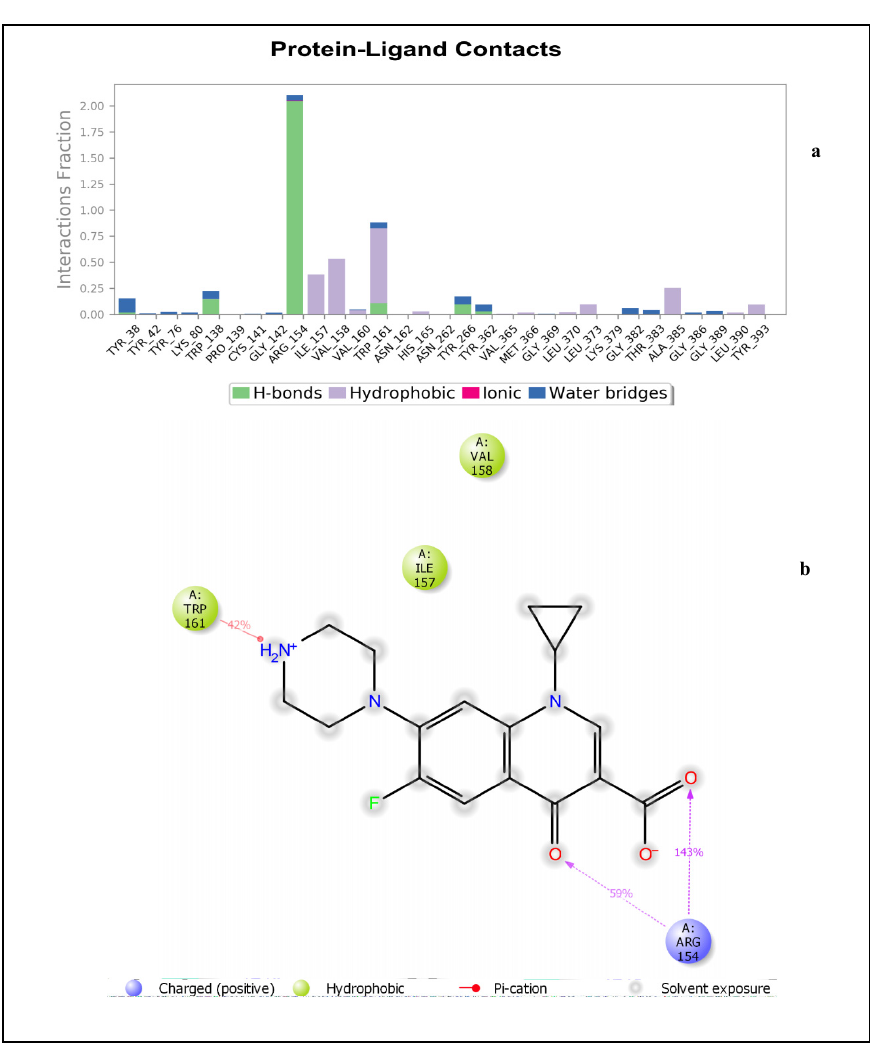
Figure 6. ( a ) Bar chart plot detailing protein-ligand interactions of ciprofloxacin-NorA complex with the key amino acid residues in the active site cavity. ( b ) Simulation interaction diagram detailing the interaction of ciprofloxacin with NorA that occur in 30% of simulation time from 0–100 ns.